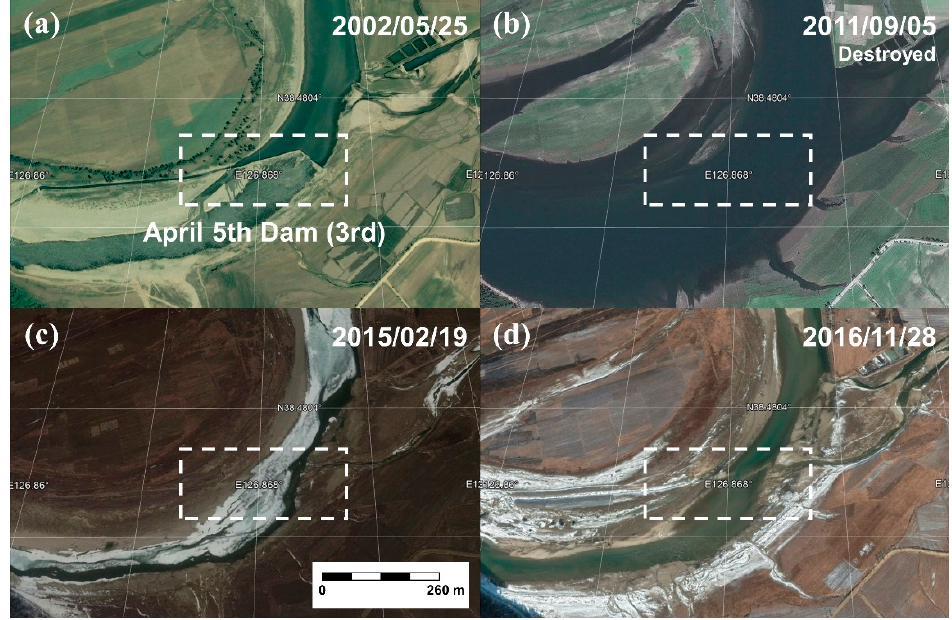
Figure 4. Images of the Third April 5th Dam from 2002 to 2016 (Lat 38.4789° N, Lon 126.8687° E, map data ©2019 Google, Maxar Technologies).